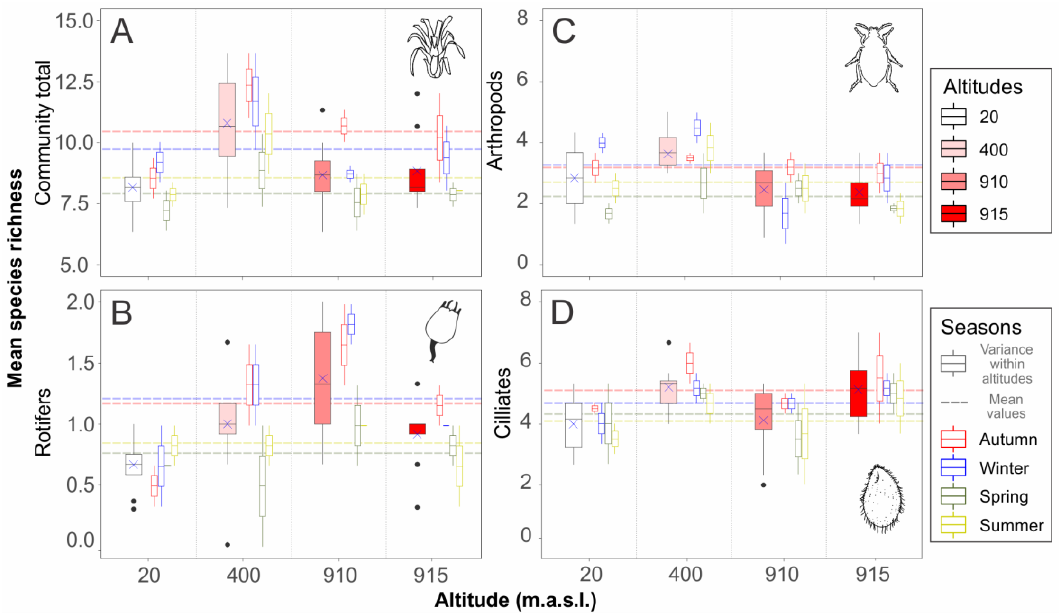
Figure 2. Species richness of phytotelmata community at di ff erent altitudes along four sampling seasons. Mean richness for the whole community ( A ) and separately for Rotifers ( B ), Arthropods ( C ), and Ciliates ( D ). Wide black-lined boxes: pooled variation comprising all sampling seasons within each altitude, with mean richness values indicated by blue crosses. Narrow colored boxes: seasonal richness variation within each altitude. Dashed colored lines: mean richness values per season, pooled values for all altitudes. See Table 2 for test results. V. gigantea at sea level (20 m); V. incurvata at intermediate altitude (400 m); V. friburgensis and V. platynema at high altitudes (910 and 915 m, respectively). Table 2. Relationships between richness descriptors of phytotelmata community and altitude and regression models that included richness descriptors as dependent variables and season + altitude as independent variables. Significant models and independent predictors (analysis of variance) in bold. Significant pairwise differences between categories of the independent variables derived from permutational post-hoc tests.